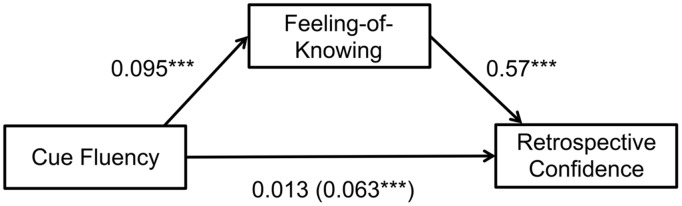
Feeling-of-Knowing (FOK) judgments mediate the effect of cue fluency, as measured by the change in fixations to the scene cue from study to test, on retrospective confidence judgments (RCJs). Value in parentheses represents the effect of scene fixations on retrospective confidence when FOKs are not modeled as a mediator. ∗∗∗p < 0.0001.